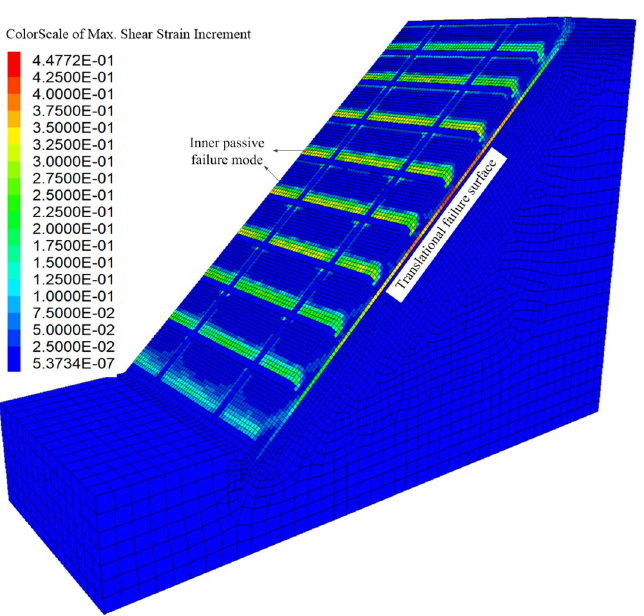
Figure 7. 3D view of the maximum shear